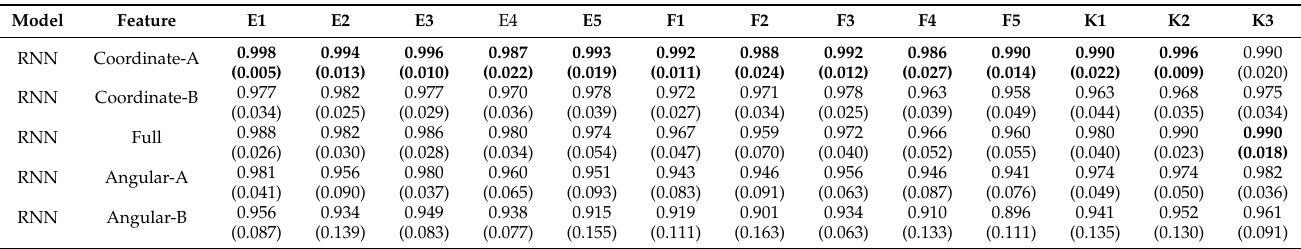
Table 14. Average AUROC result obtained by RNN model. Numbers in parentheses denote standard deviation and the text in bold denotes the best performance for each drawing pattern. E, F, and K denote English, freestyle, and Korean patterns,